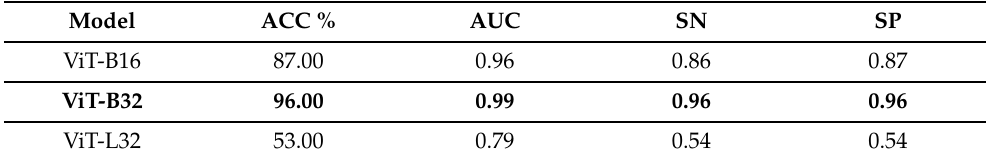
Table 2. ACC, AUC, SN, and SP of our deep Vision Transformers models for detecting COVID-19, Pneumonia, and